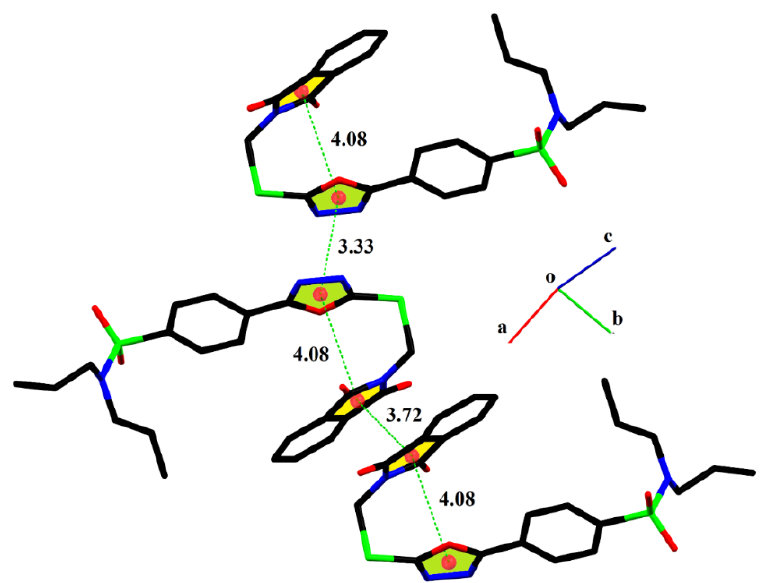
Figure 4. Graphical representation of intra- as well as inter-molecular offset π · · · π stacking interac- tions. For the purpose of clarity, hydrogen atoms are skipped. Distances are in Å. The inter-centroid separation of the intermolecular offset π · · · π stacking interactions is observed in the range of 3.33–3.72 Å, forming a chain of molecules along the [110] direction. The similar five-membered rings of the symmetry-related molecules are involved in inter-molecular offset π · · · π stacking interactions with the ring offset, or slippage ranges from 1.396 to 1.994 Å. The CH from one of the propyl groups participates in the C-H · · · π interaction with the aromatic ring of the symmetry-related molecules (1 + x, y, z), which forms an infinite chain of molecules that goes along the a -axis (Figure 5a, Table 2). An intra- molecular C-O · · · π interaction is found in PESMP with an O · · · π distance of 3.2430(12) ◦ and a C-O · · · π angle of 90.74(9) ◦ [26]. In crystal packing, the inter-molecular C-O · · · π interaction shows an O · · · π distance of 3.2417 (12) Å and a C-O · · · π angle of 80.93(8) ◦ , which interlink the molecules in the form of dimers (Figure 5b, Table 2).